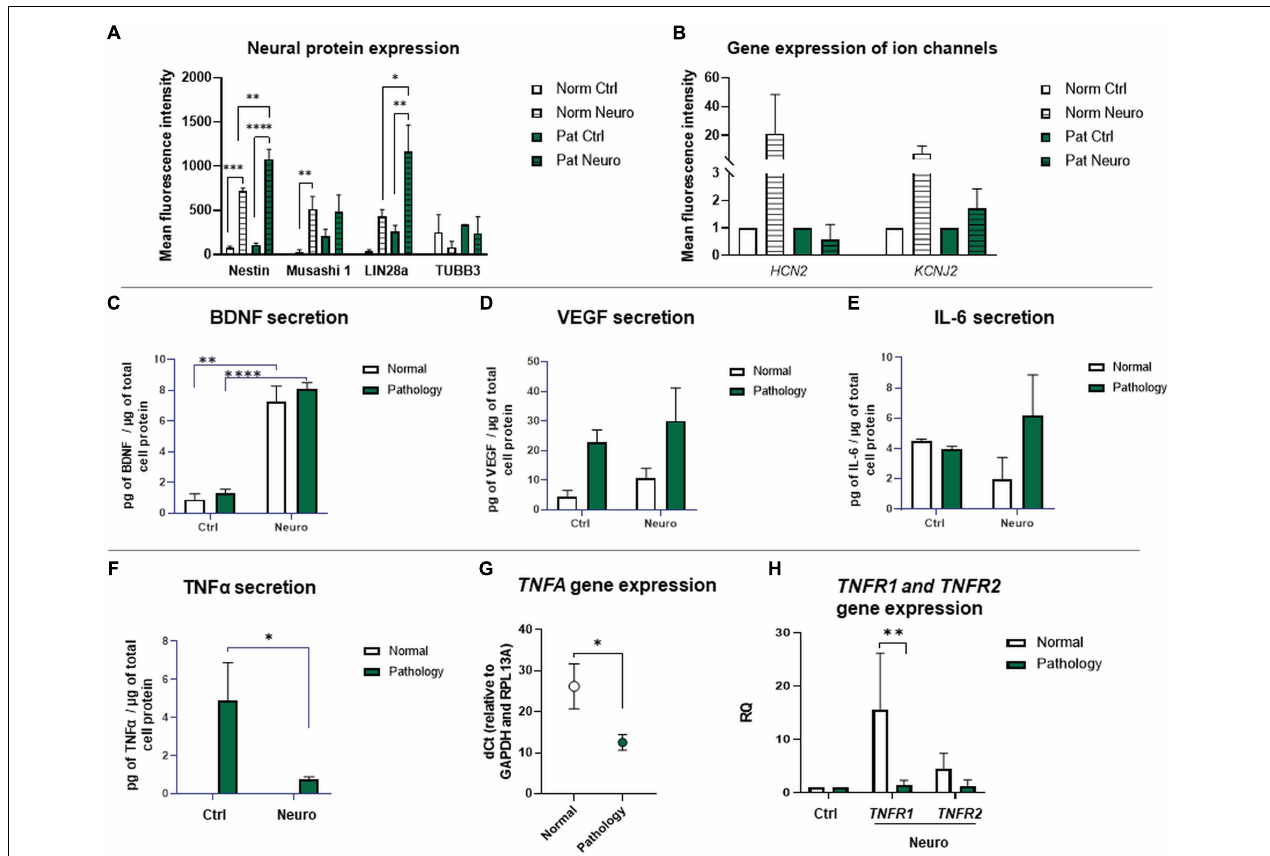
FIGURE 8 | Gene expression of ion channels and protein expression of neuro-induced hAFSCs from fetus-affected vs. fetus-unaffected gestations. (A) Expression analysis of neuronal differentiation-associated proteins Nestin, Musashi 1, LIN28a, and TUBB3. Protein expression was evaluated flow cytometrically, estimating the mean fluorescence intensity. Values are indicated as mean ± SD ( n = 3). Neural differentiation was induced after 24-h exposure to pre-induction media, enriched with 20 ng/ml FGF and 20 ng/ml EGF, and further 72-h treatment with neuronal differentiation-inducing cell culture media, supplemented with 50 ng/ml BDNF, 100 ng/ml NGF, 5 mM KCl, and 2 µ M RA (see II protocol in section “Materials and Methods,” Table 1 ). (B) RT-qPCR analysis of HCN2 (Hyperpolarization activated cyclic nucleotide gated potassium and sodium channel) and KCNJ2 (Potassium inwardly rectifying channel subfamily member 2) neural ion channel gene expression. Gene expression analysis was performed using control hAFSCs (not treated, Ctrl) and neuronal differentiation-induced hAFSCs (differentiated for 72 h using II protocol, see Table 1 in section “Materials and Methods”) from normal (Norm, n = 3) and fetus-pathological (Pat, n = 3) gestations. RT-qPCR data are represented as relative fold change over undifferentiated control, normalized for the housekeeping genes GAPDH and RPL13A; values are indicated as mean ± SD. (C–F) Secretion levels of differentiation-associated proteins BDNF (C) , VEGF (D) , and of pro-inflammatory cytokines IL-6 (E) and TNF α (F) in undifferentiated or differentiated toward neurogenic lineage (differentiated for 72 h using II protocol, see Table 1 in section “Materials and Methods”) hAFSCs from healthy (Normal, n = 3) and fetus-affected (Pathology, n = 3) gestations. Secretion of proteins was assessed by using ELISA kits from R&D Systems. (G) RT-qPCR analysis of TNFA gene in undifferentiated hAFSCs from healthy (Normal, n = 3) and fetus-affected (Pathology, n = 3) gestations. mRNA expression levels were normalized to GAPDH and RPL13A and presented as mean values of (cid:49) Ct ± SD. (H) RT-qPCR analysis of TNF α receptor genes TNFR1 and TNFR2 in undifferentiated or differentiated toward neurogenic lineage (differentiated for 72 h using II protocol, see Table 1 in section “Materials and Methods”) hAFSCs from healthy (Normal, n = 3) and fetus-affected (Pathology, n = 3) gestations. mRNA expression levels were normalized to GAPDH and RPL13A and presented as fold change over undifferentiated control. *Denotes significant difference with p < 0.05, **denotes significant difference with p < 0.01, and ****denotes significant difference with p < 0.0001, as evaluated using Student’s t